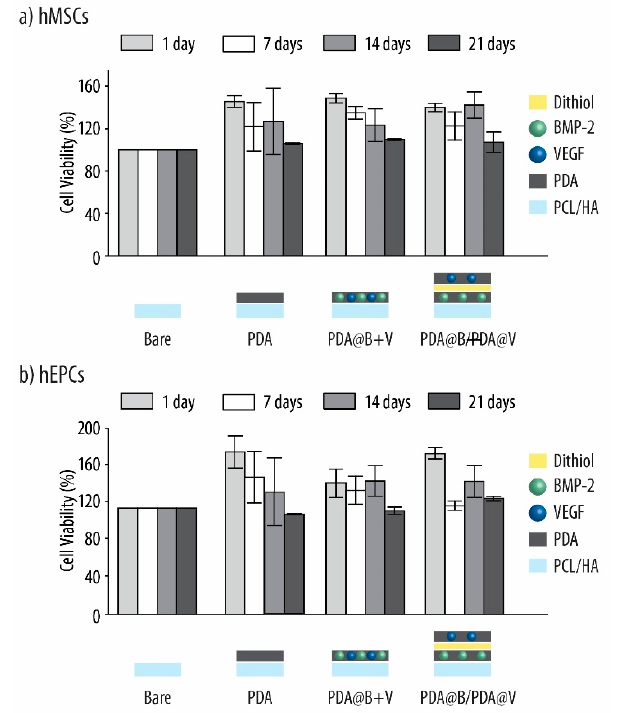
Figure A3. Cell viability of human mesenchymal stem cells (hMSCs) ( a ) and human endothelial progenitor cells (hEPCs) ( b ) onto PCL/HA scaffolds (bare), surface coated with polydopamine only (PDA), entrapping both BMP-2 (B) and VEGF (V) growth factors within the same (PDA@B+V) or in two different (PDA@B/PDA@V) PDA layers.